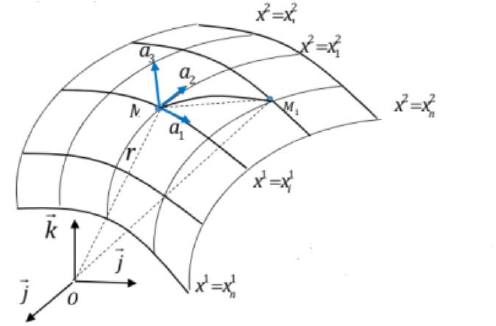
Figure 3: Surface S with its tangential basis